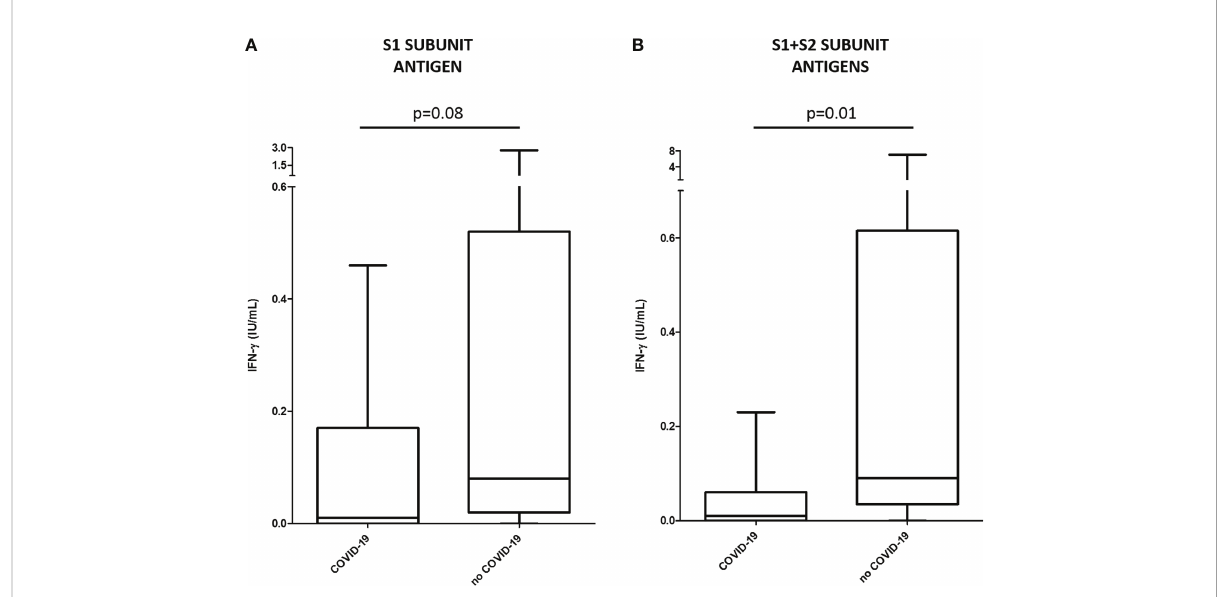
FIGURE 2 Median IFN- g levels (IU/mL) and interquartile ranges by ELISA test (QuantiFERON ® ) in patients who reported post-vaccine SARS-CoV-2 infection (COVID-19, n=9) and individuals who were not infected (no COVID-19, n=17). Cellular response was measured by stimulating with peptides derived from the S1 (A) or S1 and S2 (B) subunits of the S